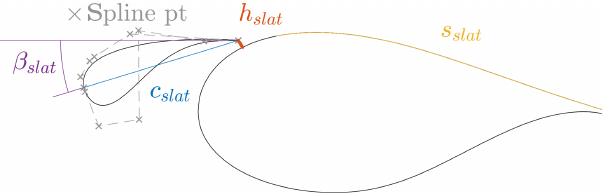
Figure 1. Visualization of the shape parameterization and the slat coordinate system parameterization (adapted from Gaunaa et al.,